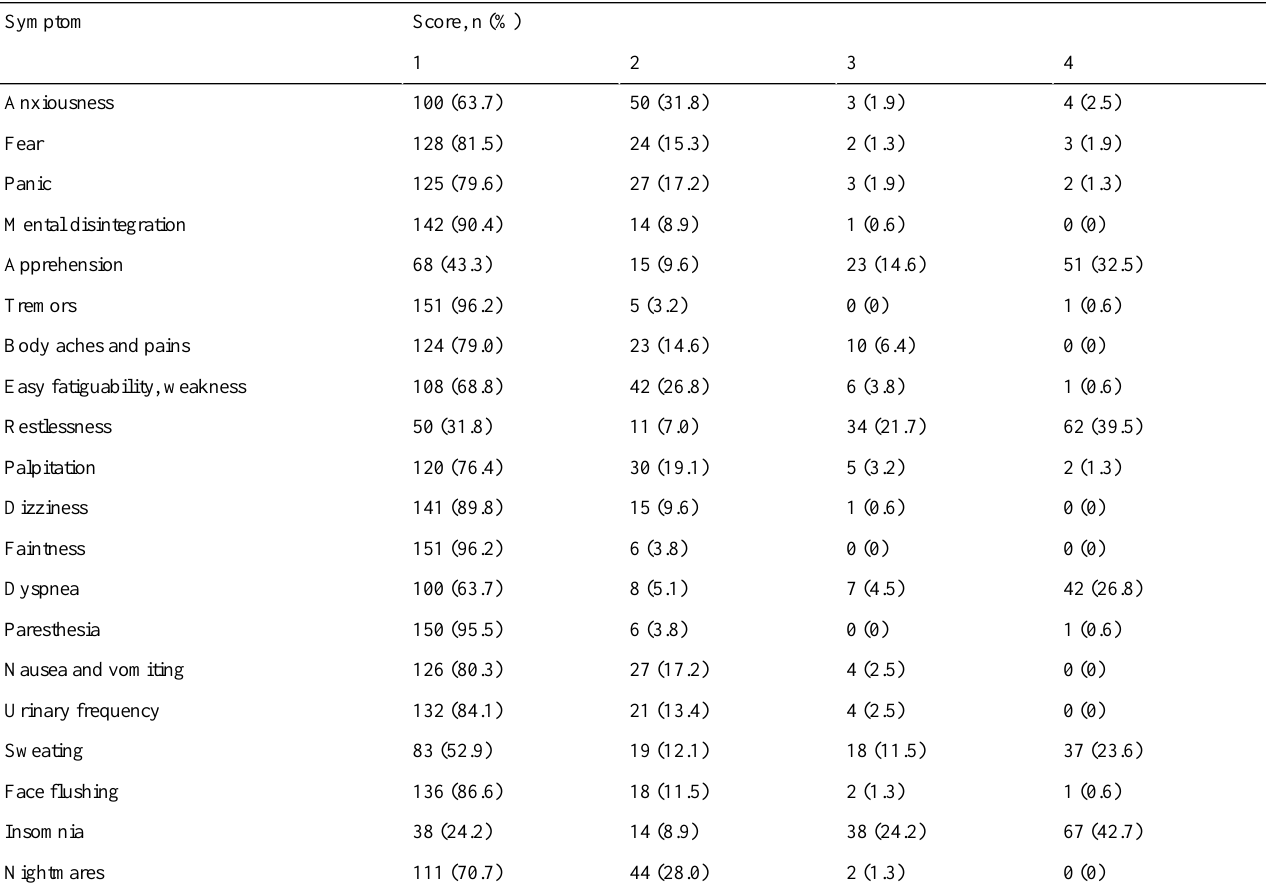
Table 2. The distribution of the Self-Rating Anxiety Scale scores of the surveyed medical students